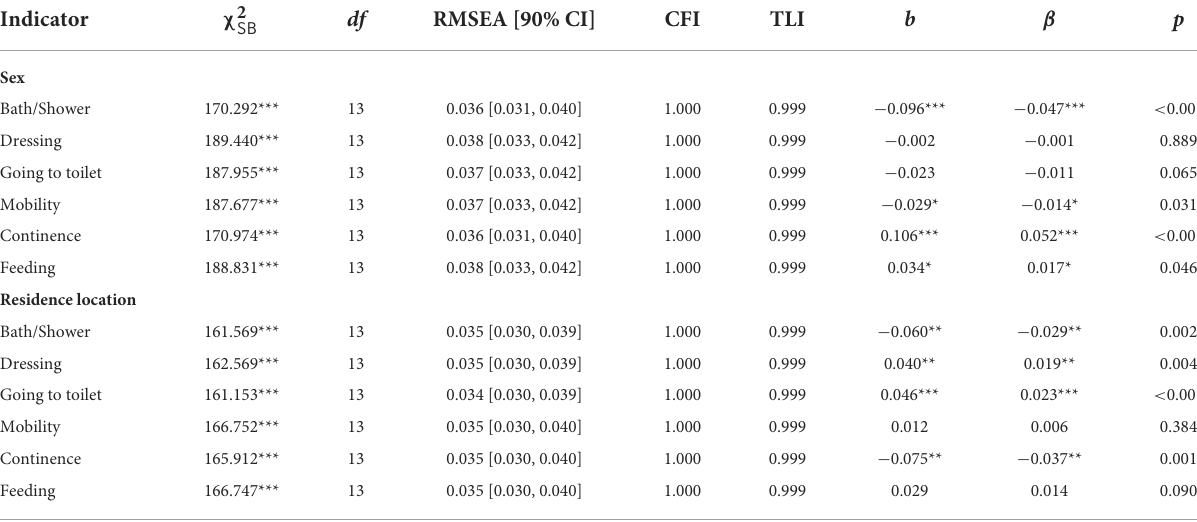
TABLE 3 Fit indices and slope coefficients for MIMIC models testing sex-related or residence-based response differences on each indicator of physical